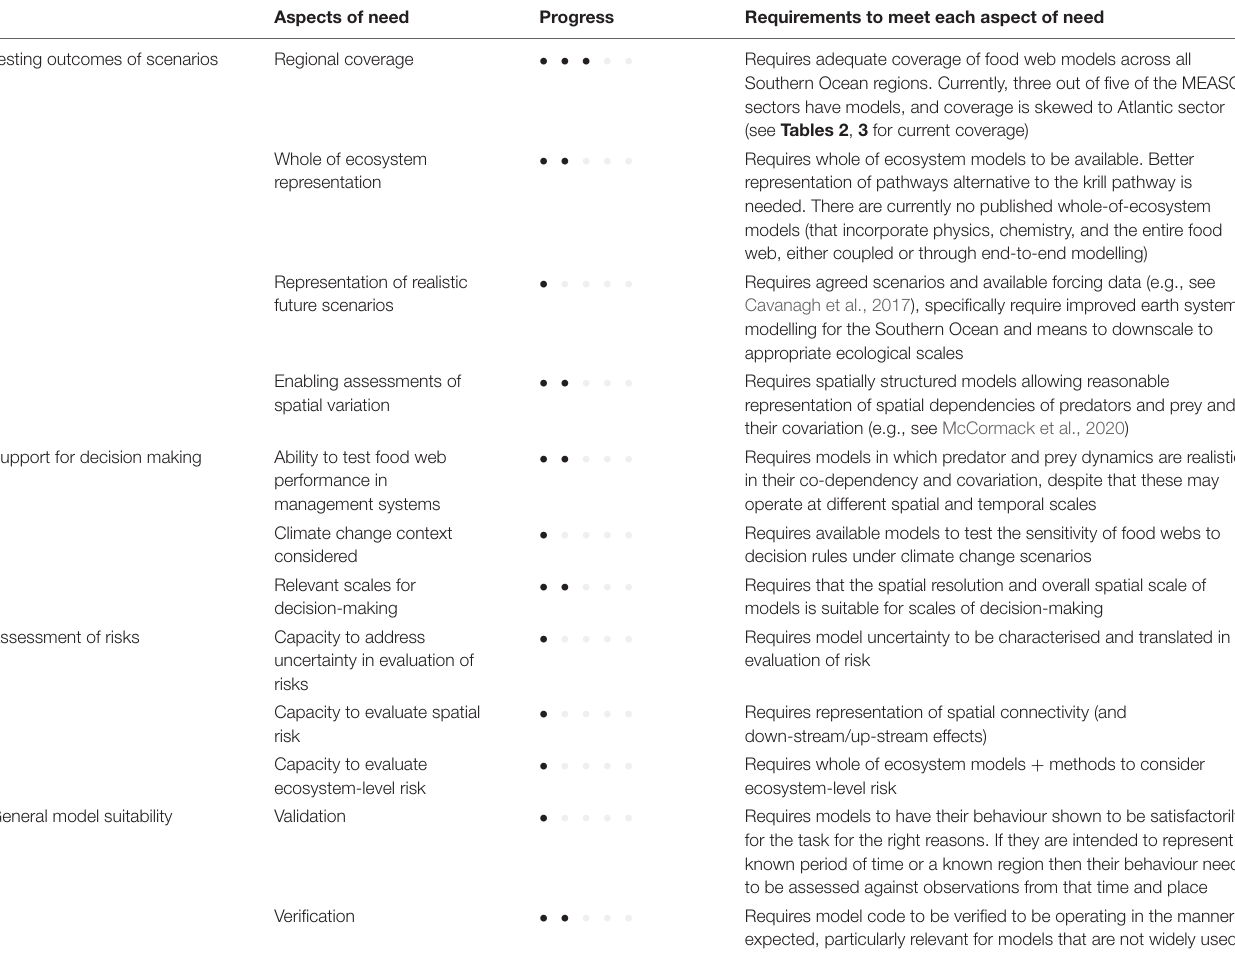
TABLE 4 | Summary of progress in the development of Southern Ocean food web models to meet three different approaches to informing policy makers and supporting decision making—testing outcomes of future scenarios, support of decision-making, and assessment of